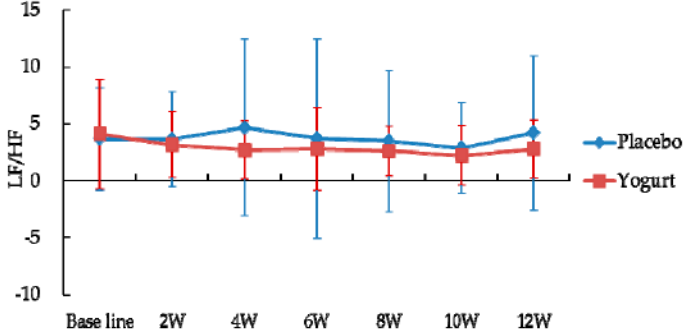
Figure 5. Effect of intake of yogurt fermented with L. bulgaricus OLL1073R-1 on autonomic nervous balance. Low frequency (LF) and high frequency (HF) indicate sympathetic and parasympathetic nervous, respectively. Data are presented as the mean ± standard